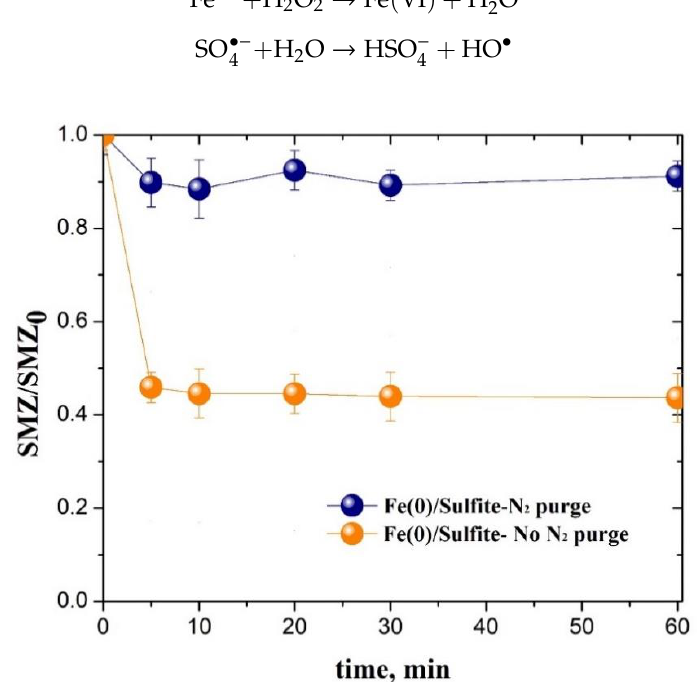
Figure 1. Degradation kinetics of sulfamethazine (SMZ) using the Fe(0)/sulfite system either in the presence or the absence of dioxygen. [SMZ] = 5.38 × 10 − 5 M, [Fe(0)] 0 = 1.79 × 10 − 2 M, [sulfite] = 5.0 × 10 − 3 M, pH 3, T = 298 K